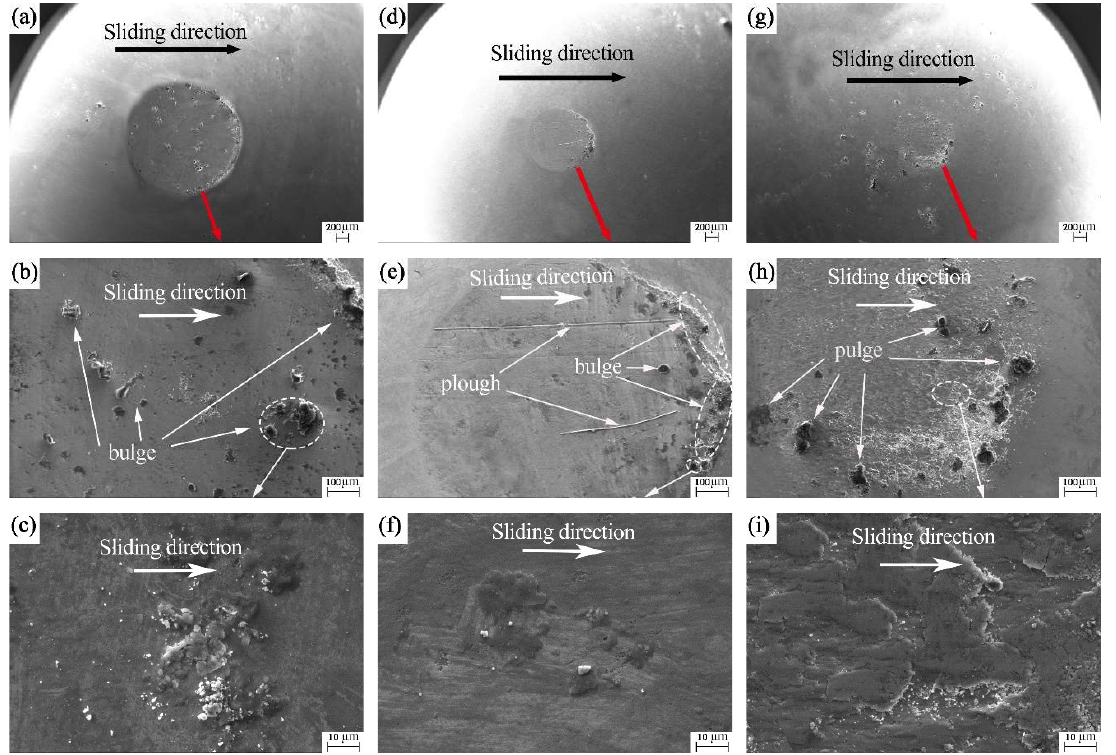
Figure 10. SEM images of the untextured worn balls: ( a – c ) rotation radius 15 mm; ( d – f ) rotation radius 18 mm; and ( g – i ) rotation radius 22.5 mm.